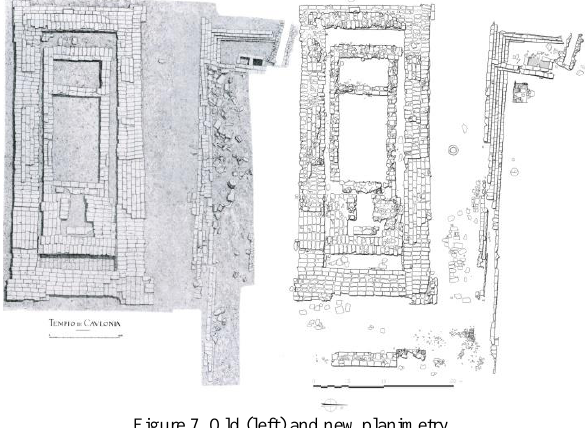
Figure 7. Old (left) and new planimetry